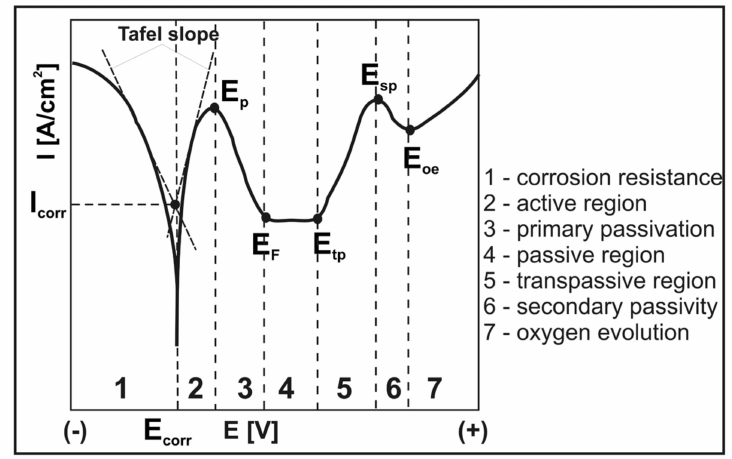
Figure 1. The scheme of a hypothetical polarization curve. E corr —corrosion potential; I corr —corrosion current density; E pp —the primary passivation potential; E F —the Flade potential; E tp —the transpassive potential; E sp —the secondary passive potential; and E oe —the oxygen evolution